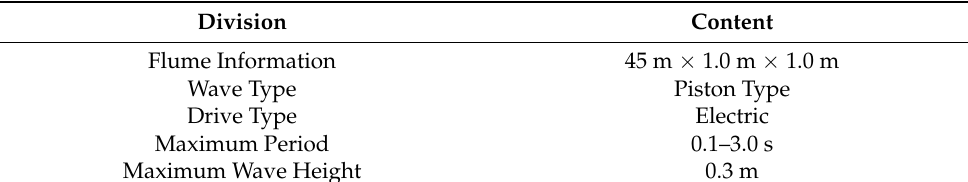
Table 4. The specification of the 2D cross-sectional wave flume.